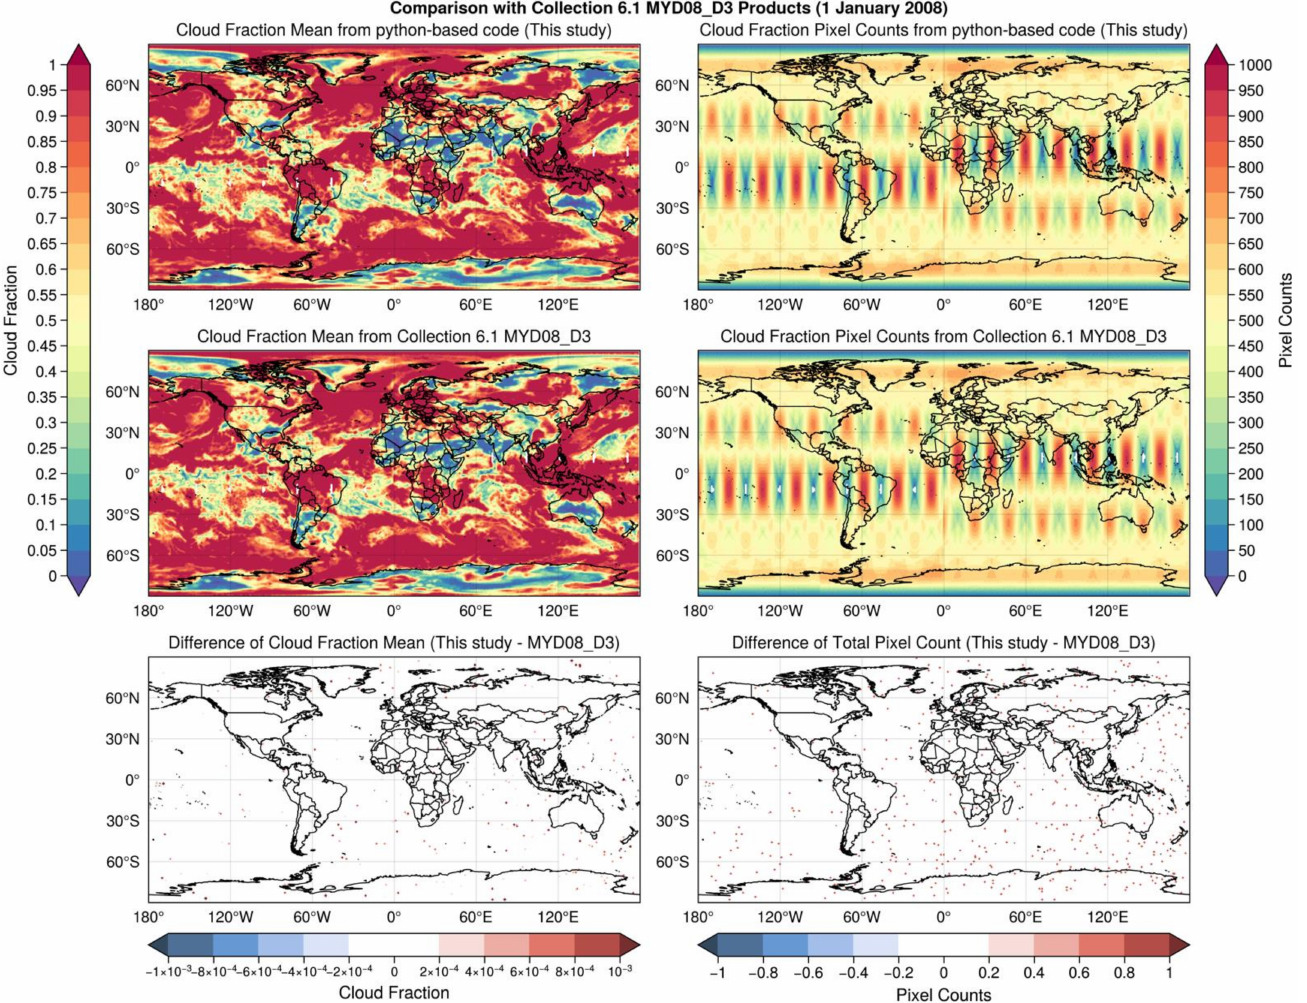
Figure 4. The comparison of the cloud fraction between the python-based algorithm and the MYD08_D3 product on 1 January